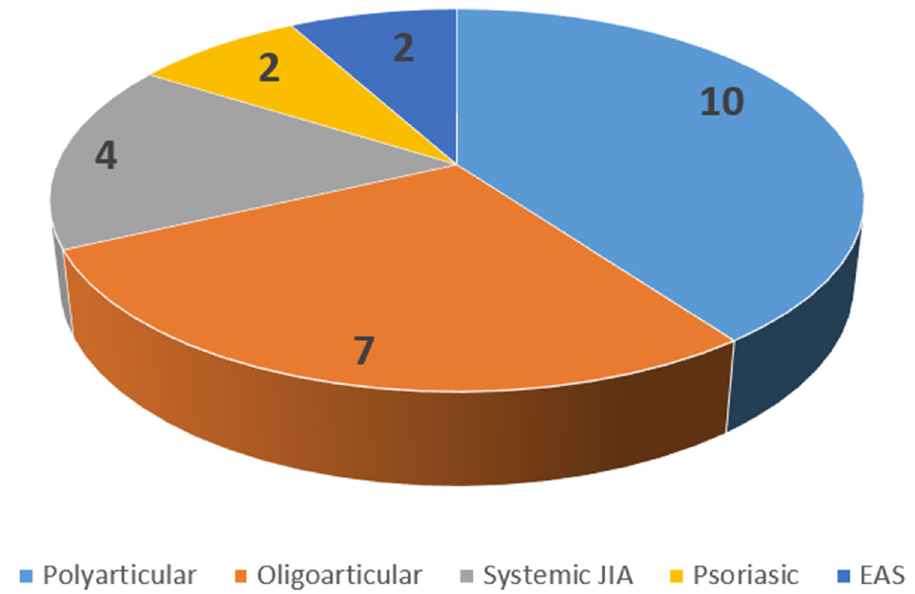
Figure 1. Distribution of JIA forms of the patient sample.